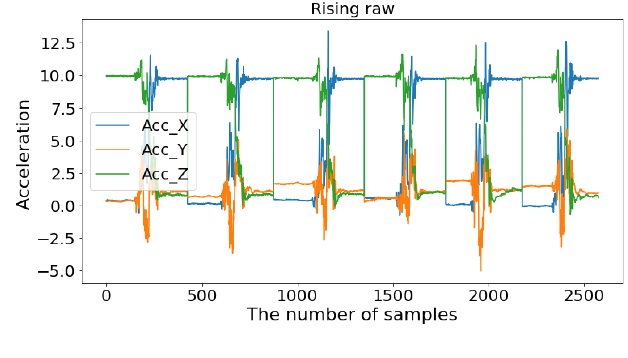
Fig 7. Rising after pre-processing.